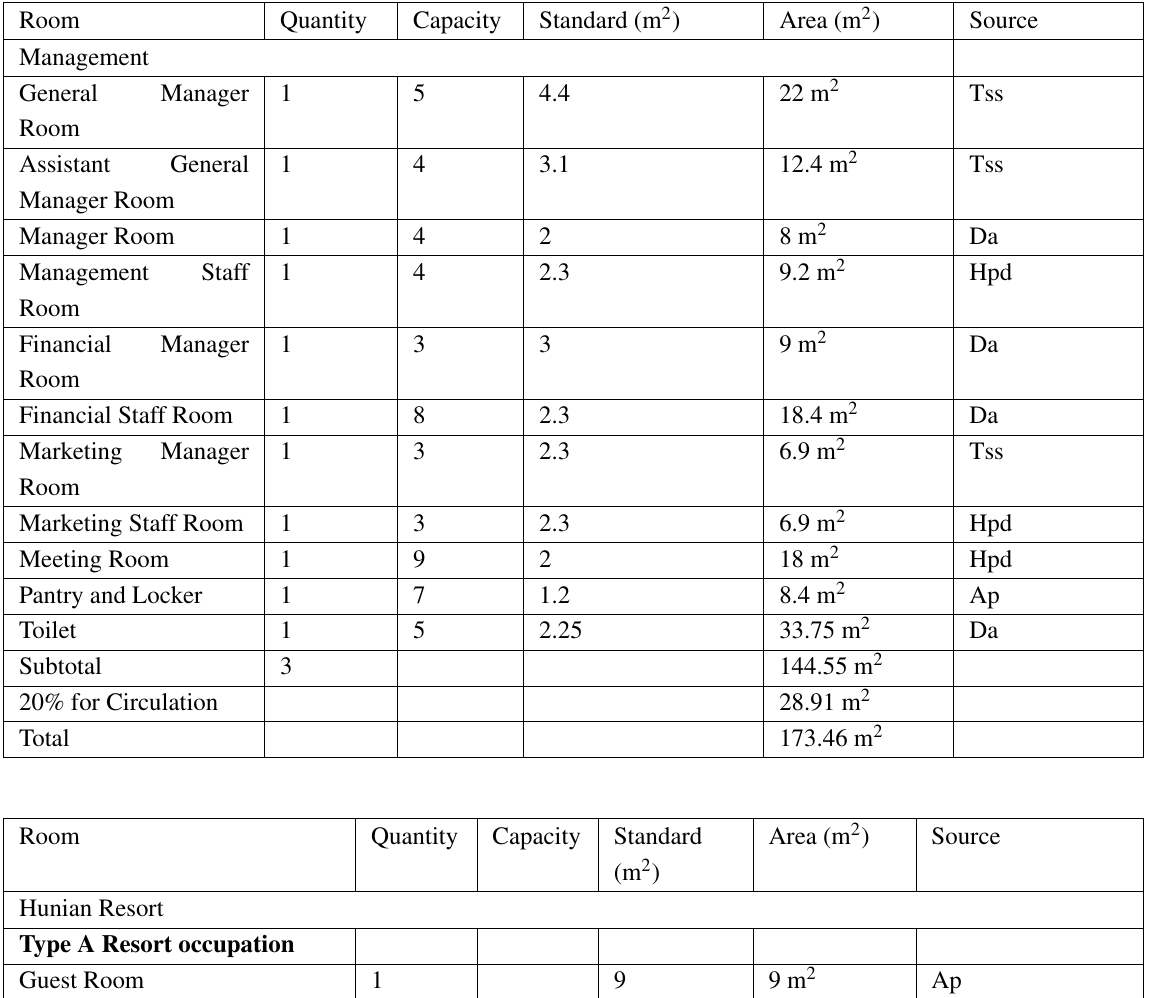
Table 1. Requirement and Room